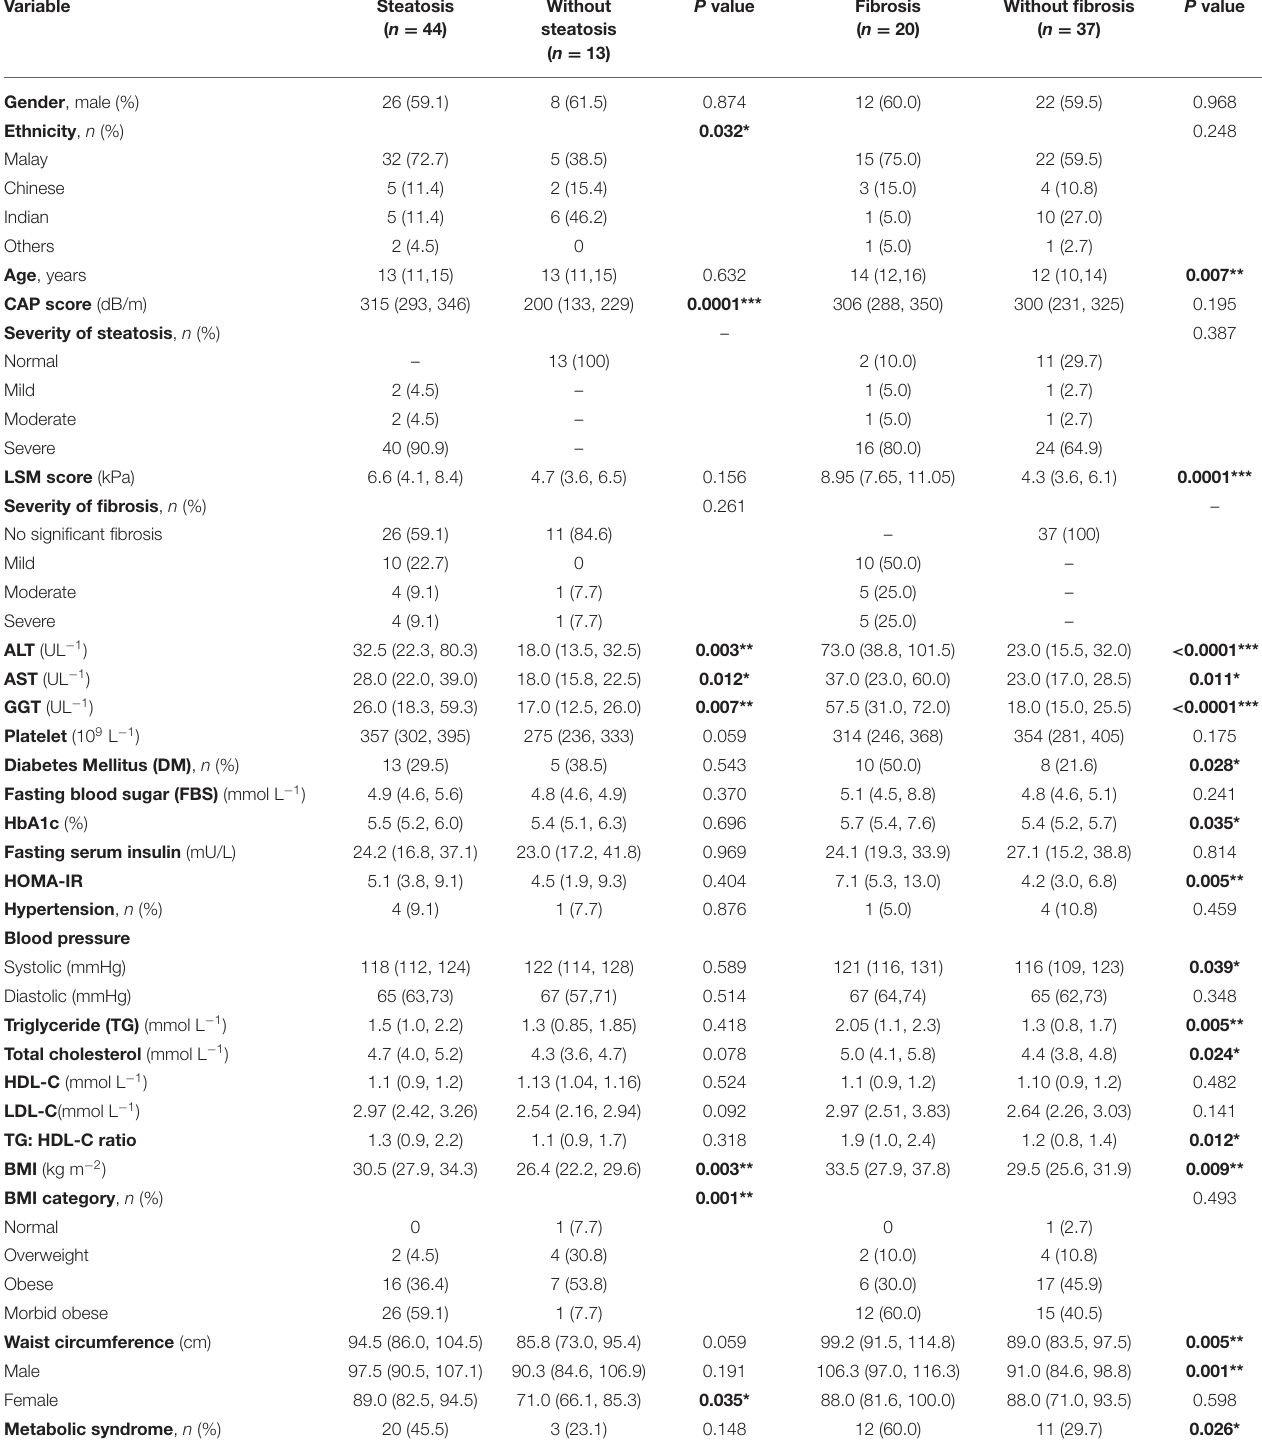
TABLE 2 | Comparison of demographic, clinical characteristics, and metabolic factors between children and adolescents with or without liver steatosis and with or without liver fibrosis.